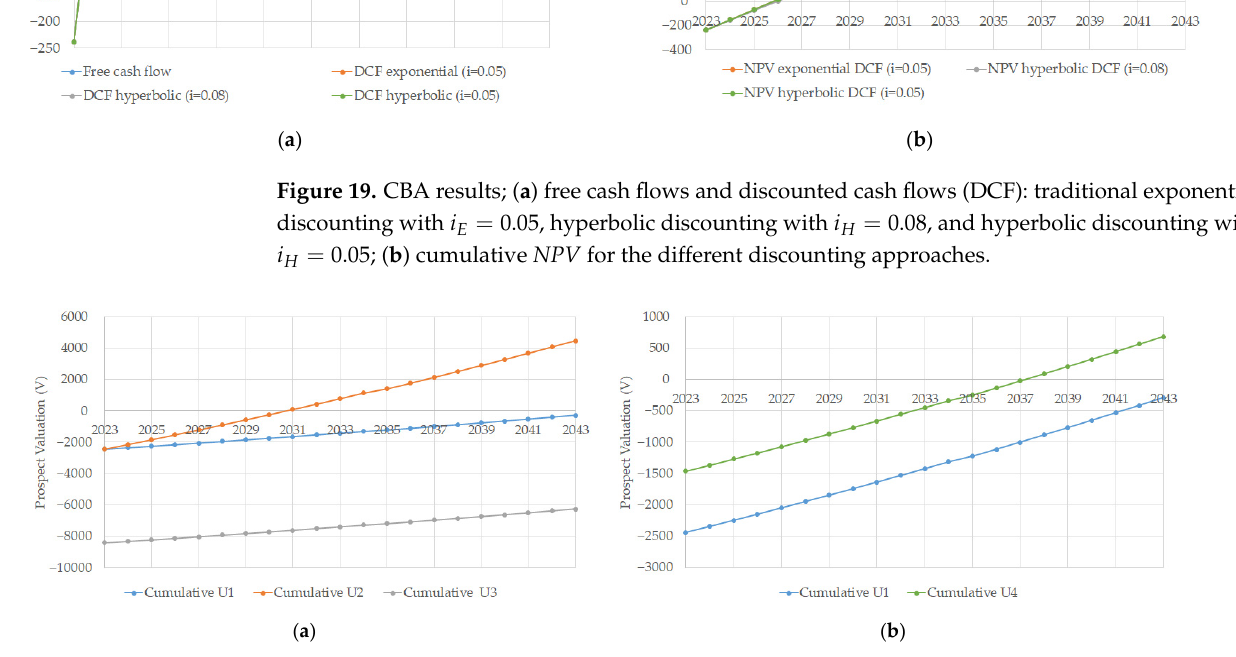
Figure 20. Valuation prospect for different combinations of diminishing sensitivity to gains and losses, and loss aversion; ( a ) baseline valuation ( U 1 ) and sensitivity to diminishing sensitivity to gains ( U 2 ) and to losses ( U 3 ) ; ( b ) baseline valuation ( U 1 ) and sensitivity to loss aversion ( U 4 ).